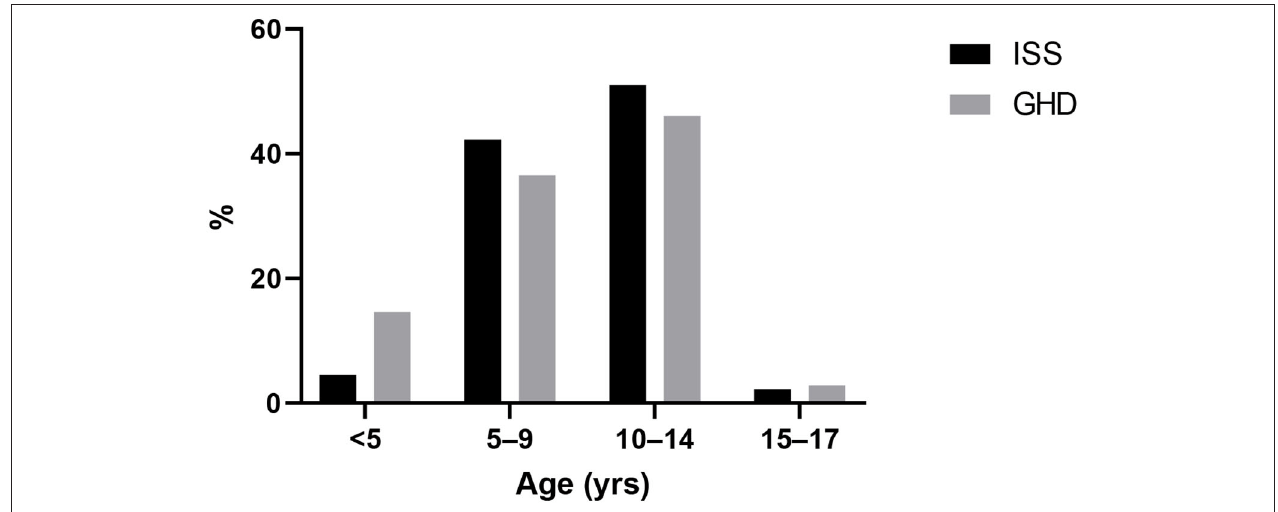
FIGURE 2 | Age at initiation of growth hormone treatment. ISS, idiopathic short stature; GH, growth hormone; GHD, growth hormone deficiency.